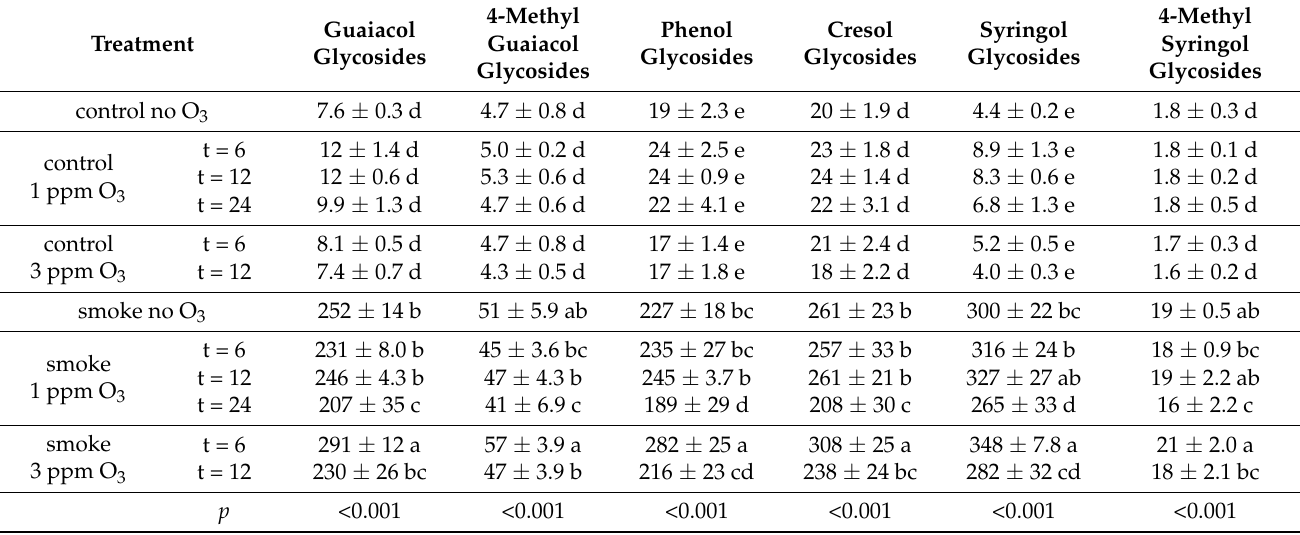
Values are means of three replicates ( n = 3) ± standard deviation measured as syringol glucose-glucoside equivalents. Different let- ters (within columns) indicate statistical significance ( p = 0.05, one way ANOVA). Smoke exposure occurred at approximately 7 days